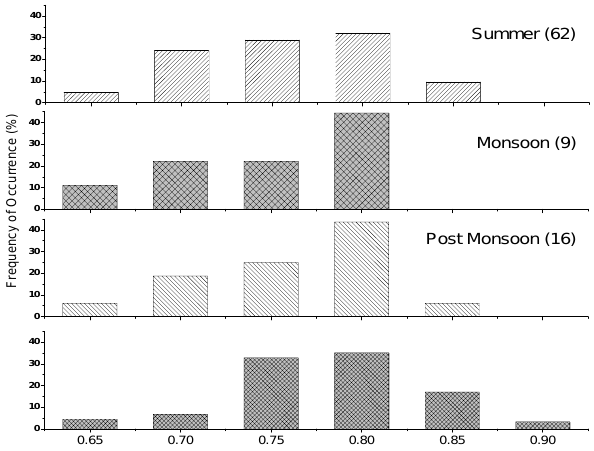
Fig. 4. Frequency of occurrence of SSA (at 550nm) during summer, monsoon, post-monsoon, and winter seasons (2007). Parenthetical numbers represent number of observations for each